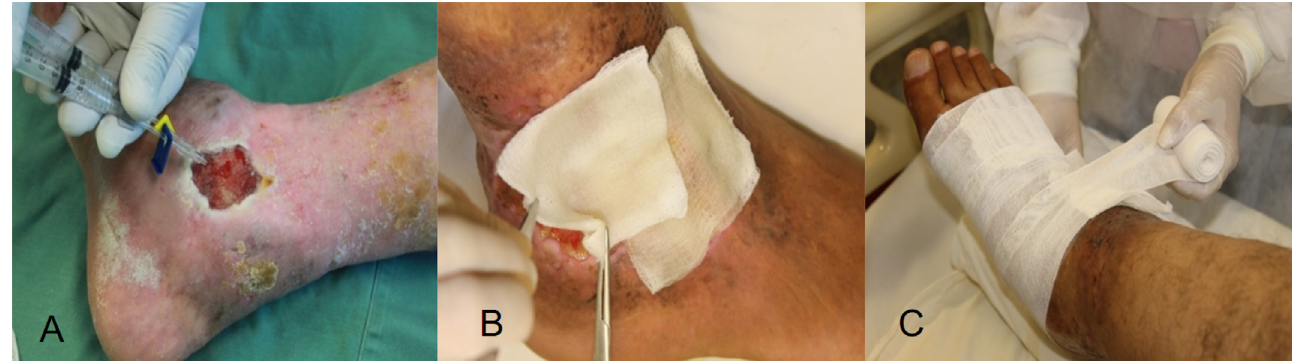
Figure 3. (A) Application of the product to an ulcer with fibrin polymerization to form a colorless gel in between 2 and 5 minutes. (B) Gauze soaked in essential fatty acids, in a quantity sufficient to cover the entire ulcerated surface. (C) Application of Unna’s boot dorsally from the foot up to just below the